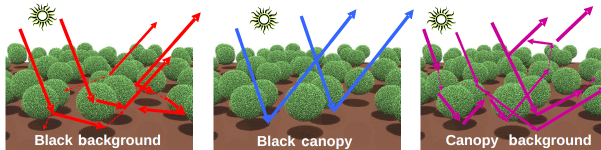
Figure 2. Decomposition of the total flux into three contributing fractions. The two-stream solution by Meador and Weaver (1980) applies to the black background contribution (left-hand side)